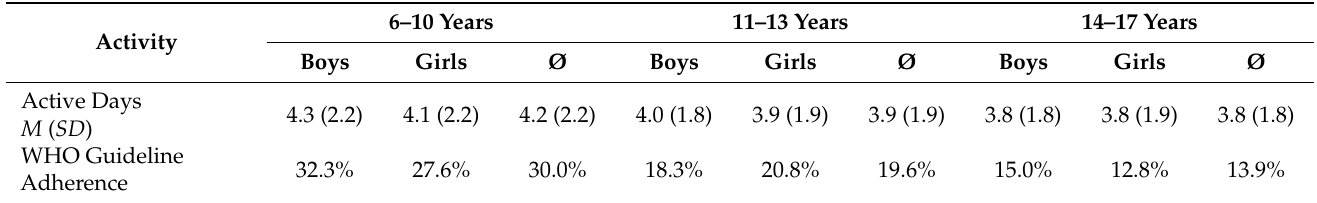
Table 2. Active days and WHO guideline adherence divided by age and gender.